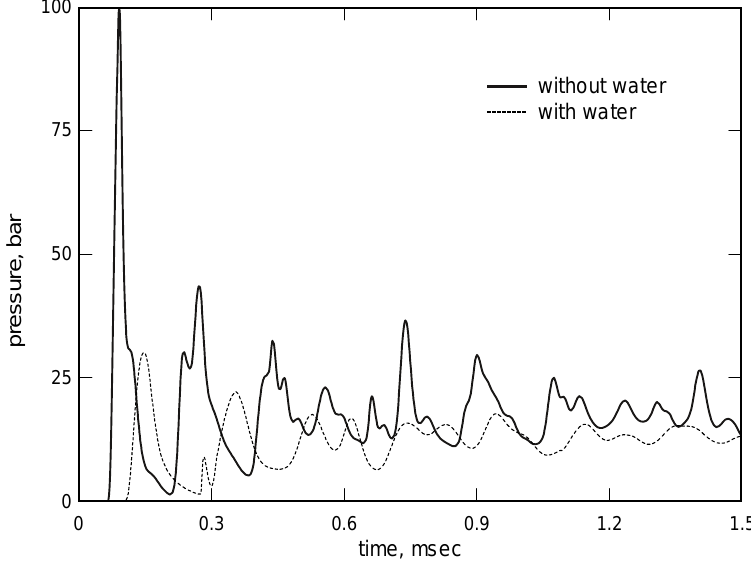
Fig. 2. Numerical Simulation of pressure signatures at pressure point P1 in the cube chamber.